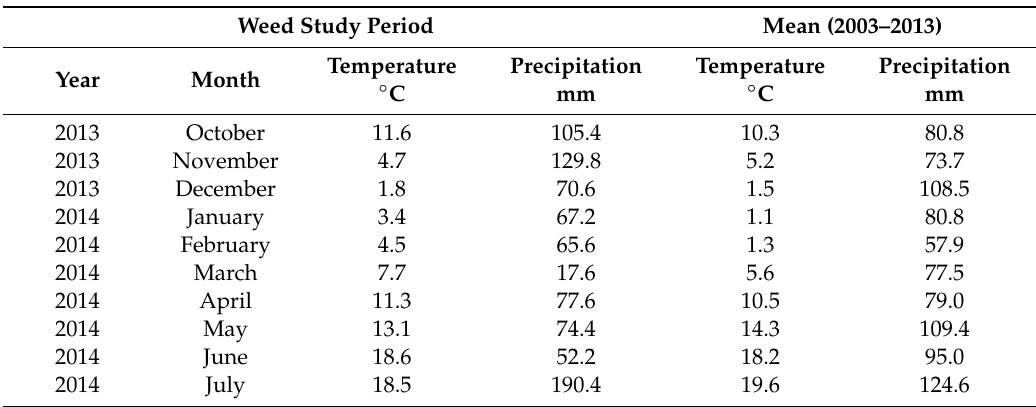
Figure A1. Total weed biomass (g dry matter m − 2 ) per tillage system and weeding treatments at different wheat stages. Fertilisation treatments were pooled. CT = ploughing, RT = reduced. Table A1. Weather data (temperature, precipitation) during the wheat-growing season considered in the weed competition study compared with the average of 2003–2013.